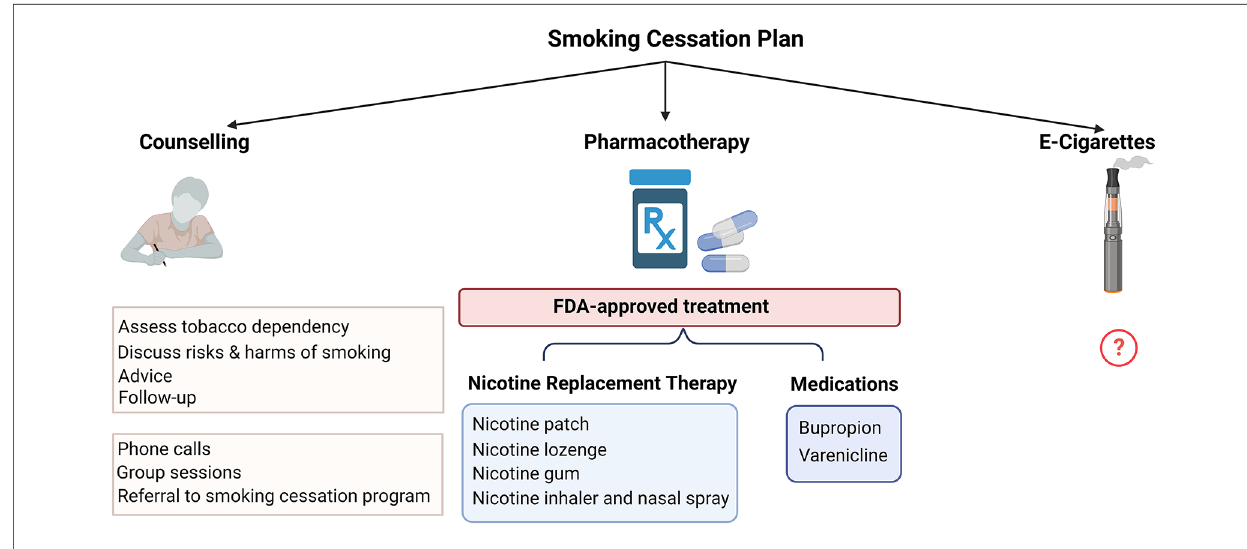
FIGURE 3 Approach to promoting smoking cessation in patients with